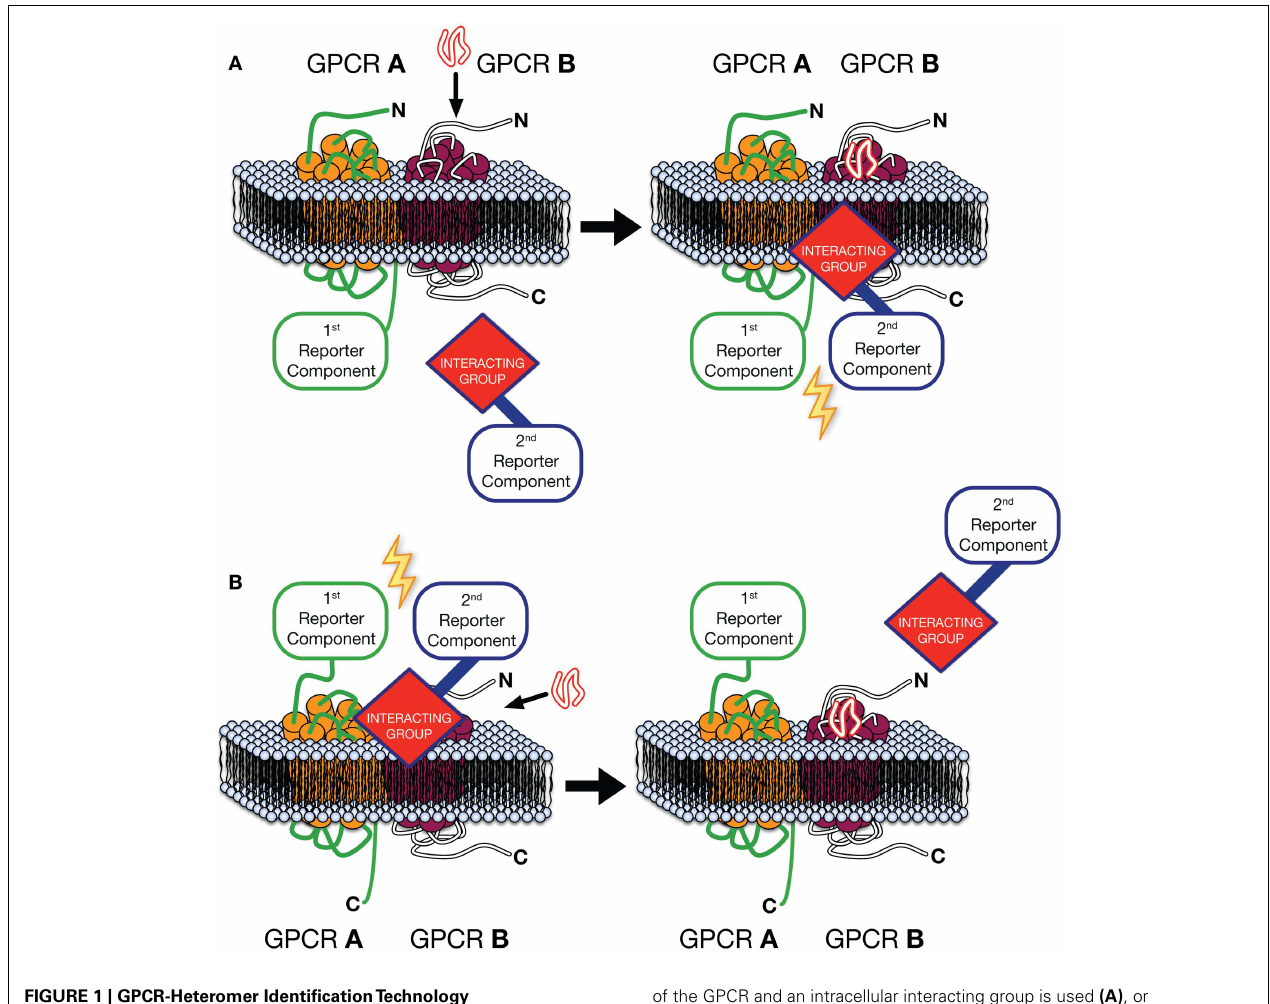
FIGURE 1 | GPCR-Heteromer IdentificationTechnology (GPCR-HIT) . GPCR A is fused to the first reporter component, GPCR B is unlabeled with respect to the reporter system, and a GPCR- interacting group is linked to the complementary second reporter component.The first reporter component is fused to the C-terminus